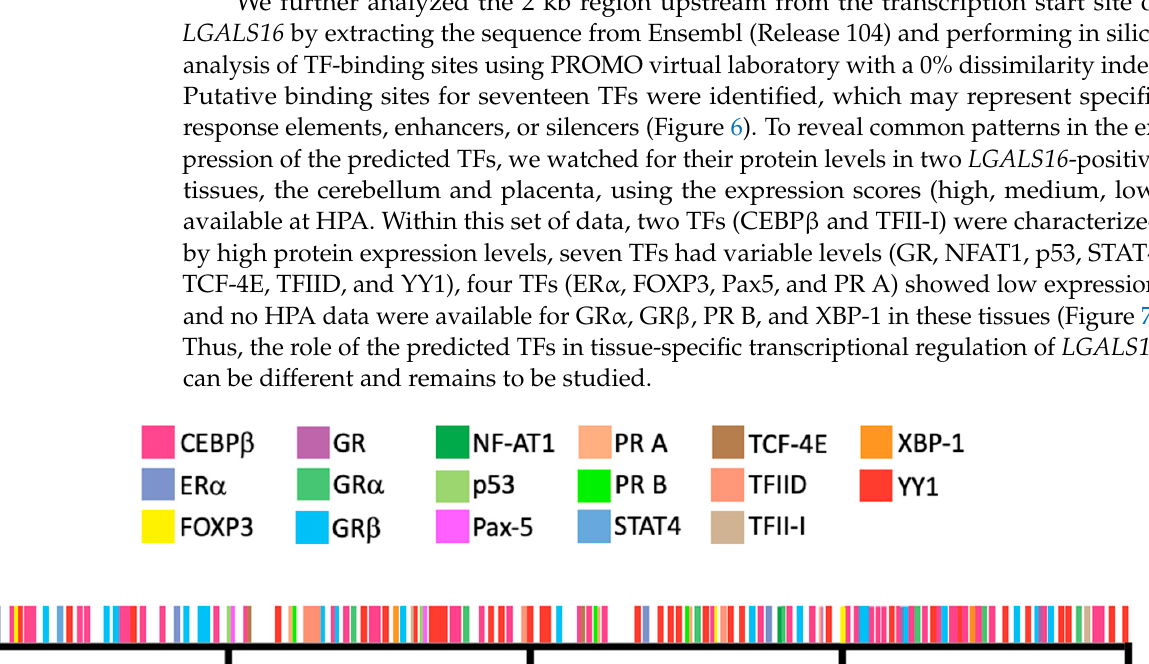
Figure 6. In silico screening of putative transcription factor binding sites for the LGALS16 gene. There are multiple binding sites for 17 transcription factors within the 2 kb promoter region up- stream the transcription start site of LGALS16 gene as detected by PROMO.